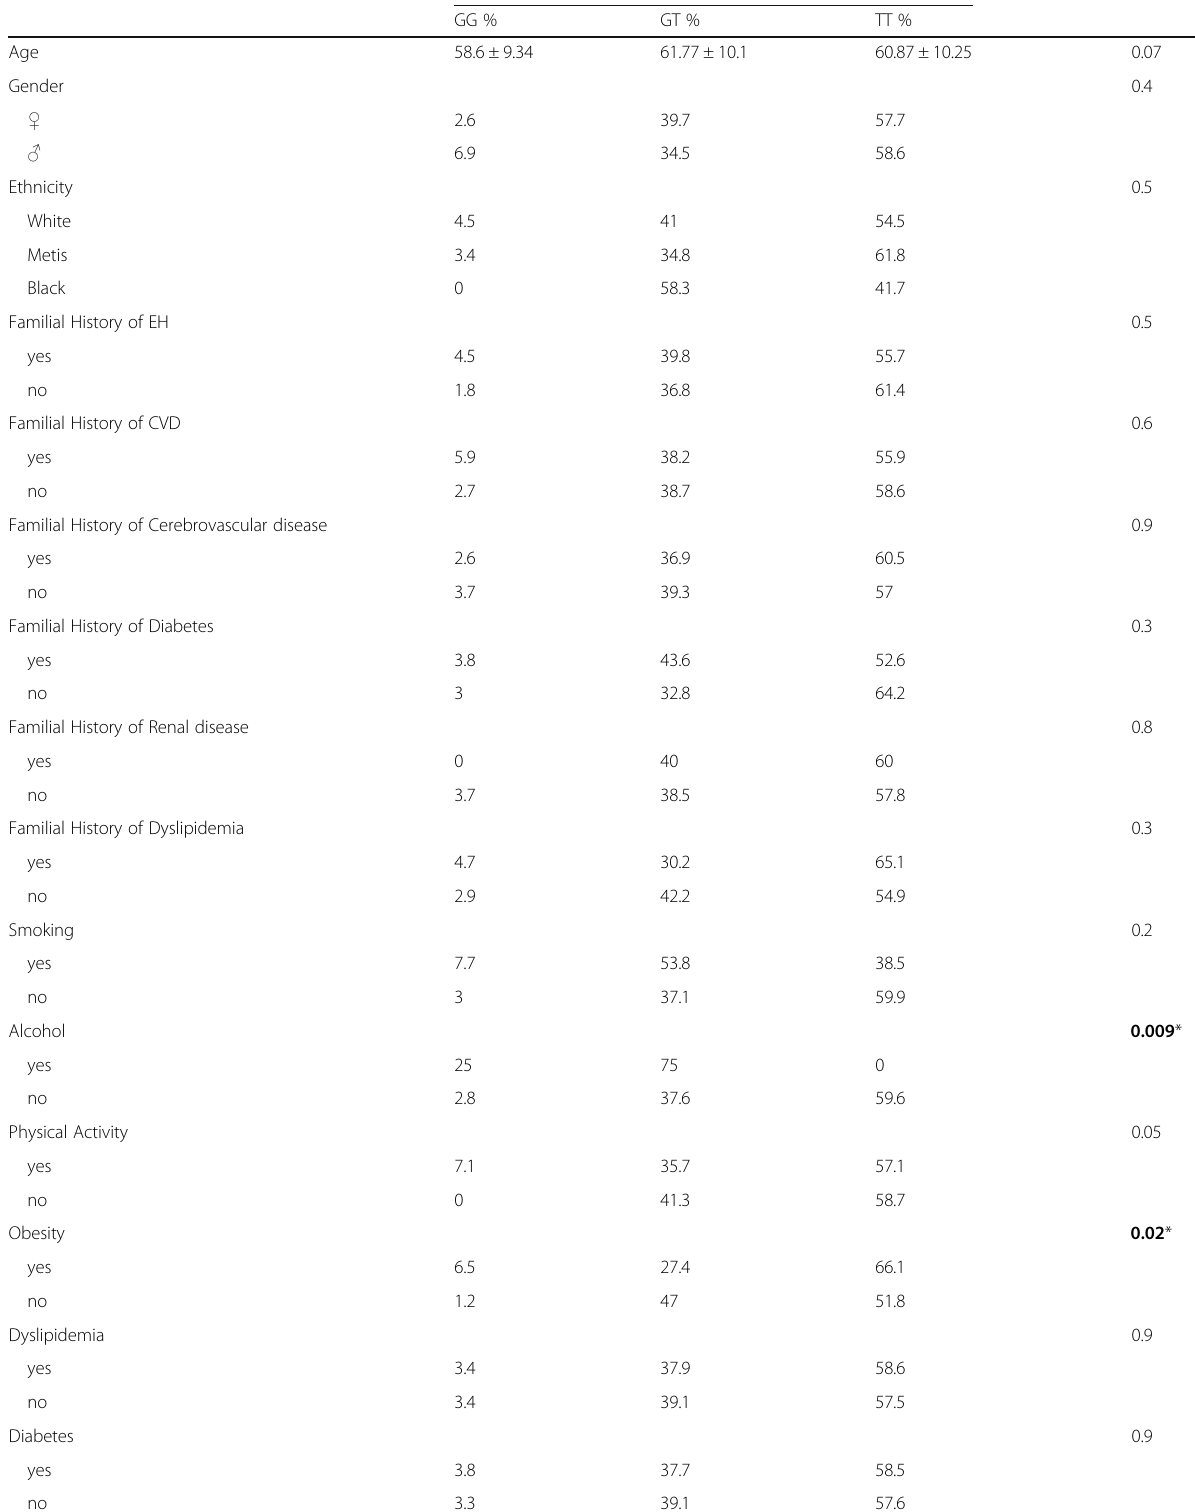
Table 1 G894 T eNOS distribution Vs Clinical